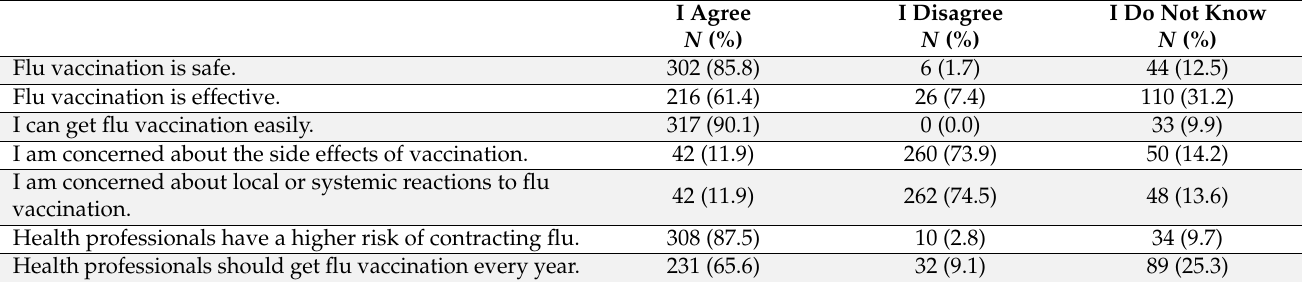
Table 4. Agreement or disagreement with statements about flu vaccination and